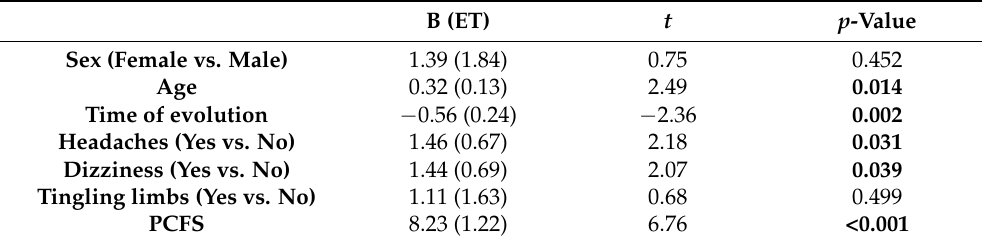
Table 3. Effect of demographic and clinical variables on the total ADLQ score.